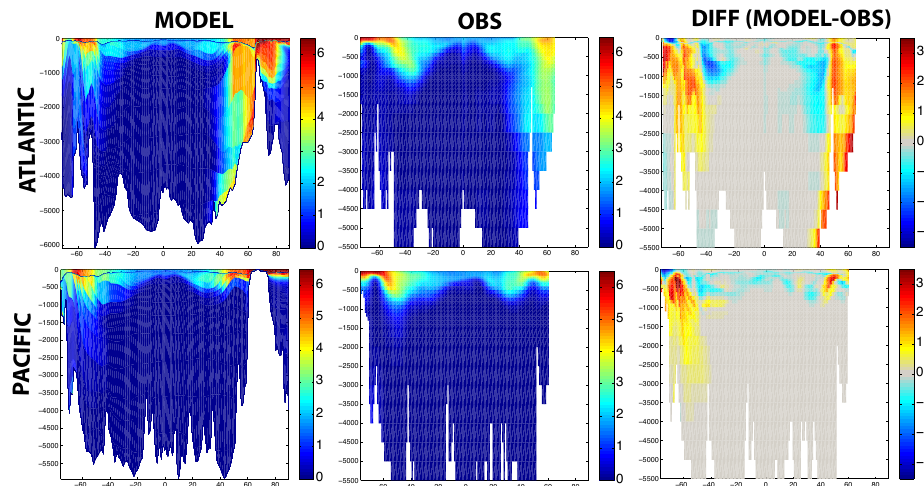
Fig. 9. Meridional sections through the western Atlantic (top) and Pacific of simulated (bottom) of simulated (left) and observed (middle) CFC11(nmoll − 1 ) and their difference (right). Model results are a mean 1988–1997 and observations from GLODAP (Sabine et al., 2005). Model results were interpolated onto the same 1 ◦ × 1 ◦ grid as the observations for the comparison.